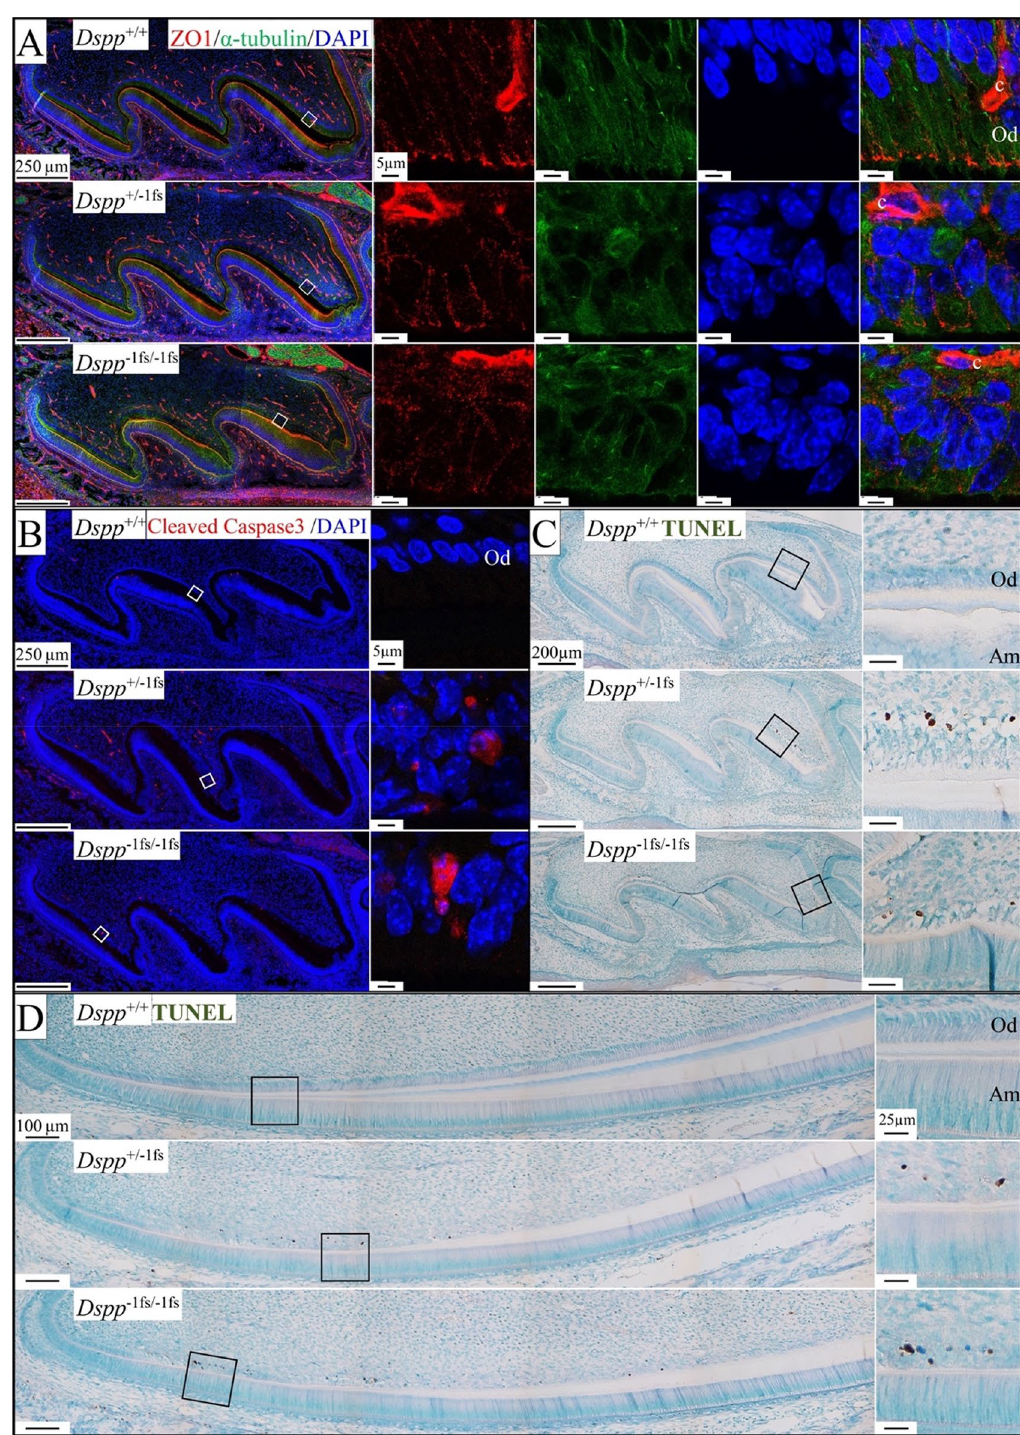
Figure 3. Loss of tight junctions and sporadic apoptosis in the odontoblasts of Dspp −1fs mice. Shown are D3 maxillary first molars (A-C) and D14 mandibular incisors (D). ( A ) Immunohistochemistry showing zonula occludens-1 (ZO1) (red; tight junctions), α-tubulin (green; boundary of cells), and DAPI (blue; nucleus). Capillaries (c) show strong ZO1 staining. In Dspp +/+ odontoblasts, ZO1 signal is observed in focal locations along the lateral plasma membrane, most prominently at the distal tight junctions. In Dspp −1fs mice, odontoblasts displayed irregular and diffuse ZO1 signals. ( B ) Immunohistochemistry of cleaved caspase 3 shows cleaved caspase 3 only in Dspp −1fs (and not in Dspp +/+ ) odontoblasts. ( C , D ) TUNEL assay. Many Dspp −1fs odontoblasts are TUNEL-positive (brown). Od—odontoblast;